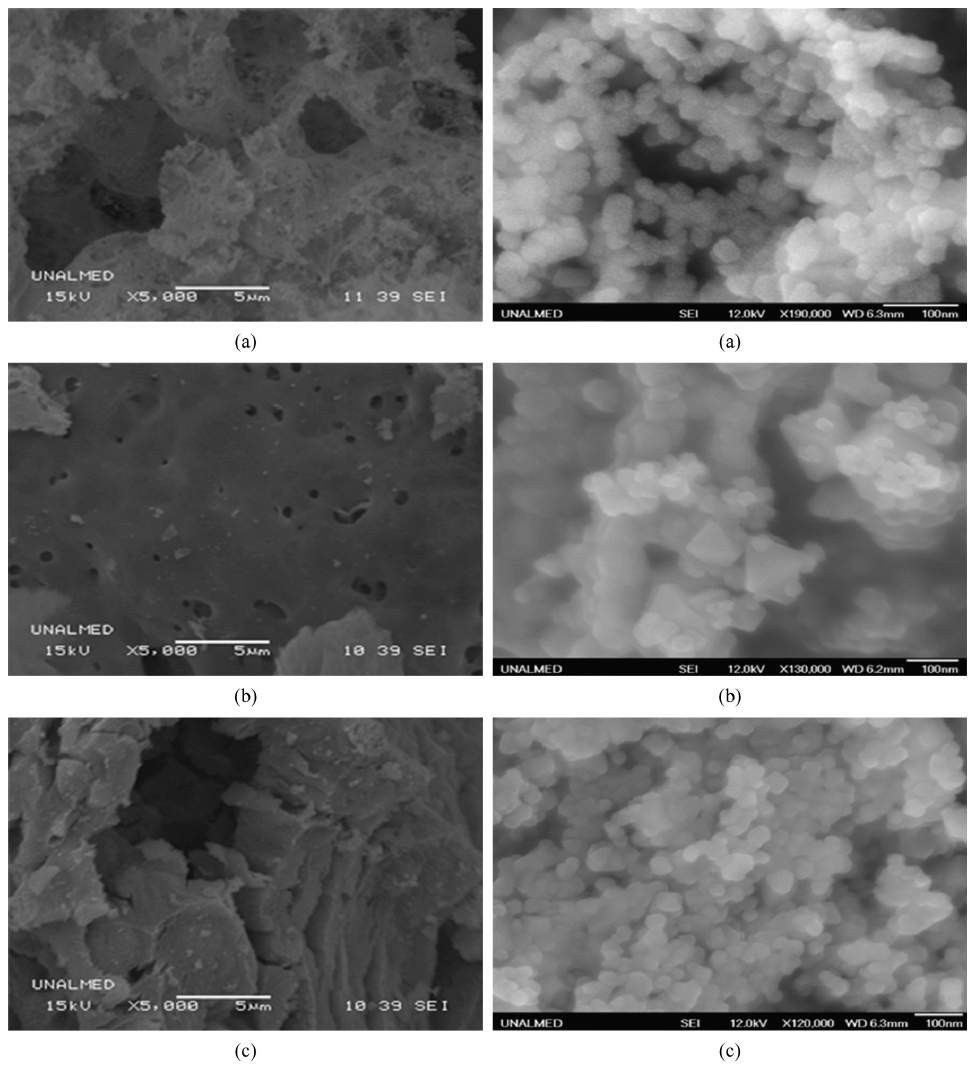
Figure 3. FESEM micrographs for ZnCr